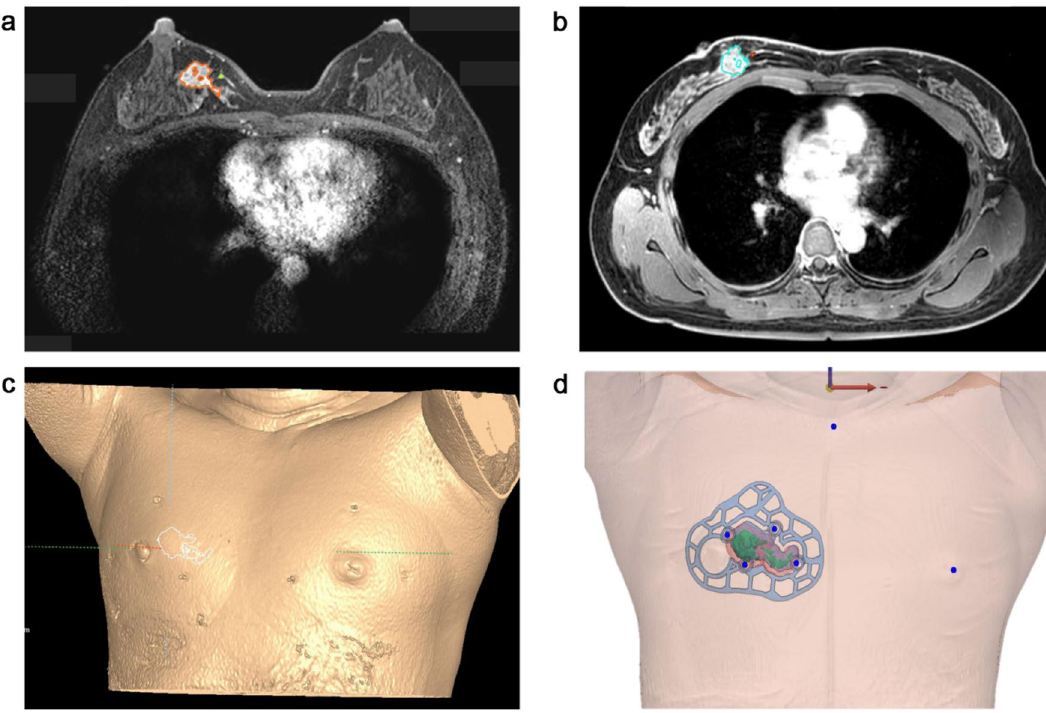
Figure 1. Segmentation of the breast and tumor in prone/supine magnetic resonance imaging (MRI) for breast surgical guide (BSG) modeling. ( a ) Segmented tumor on prone MRI, ( b ) Segmented tumor on supine MRI, ( c